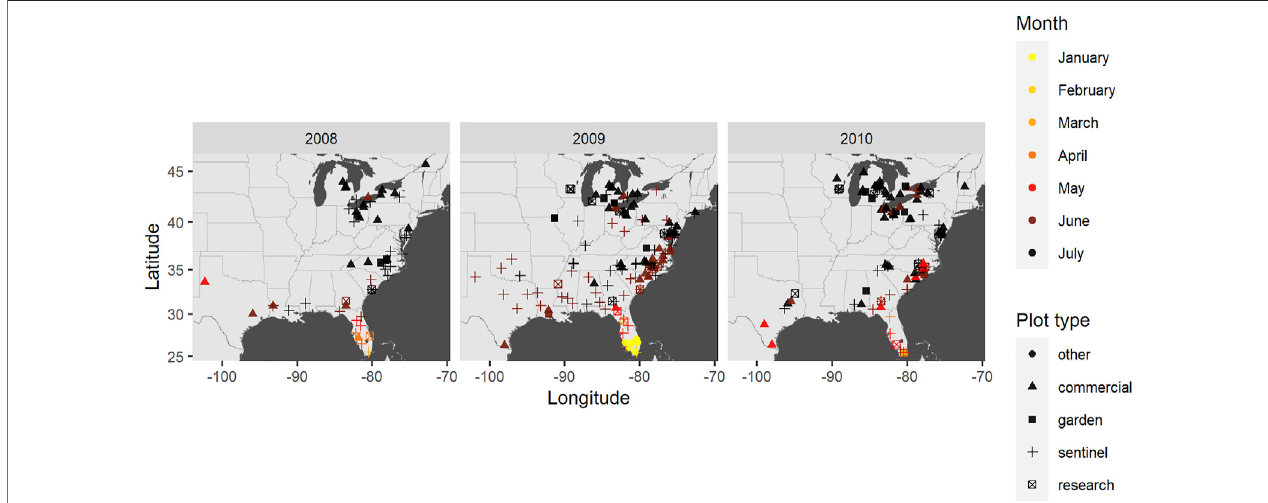
FIGURE 3 | Disease reports from 2008 to 2010 plotted by location, reported symptom date, and plot